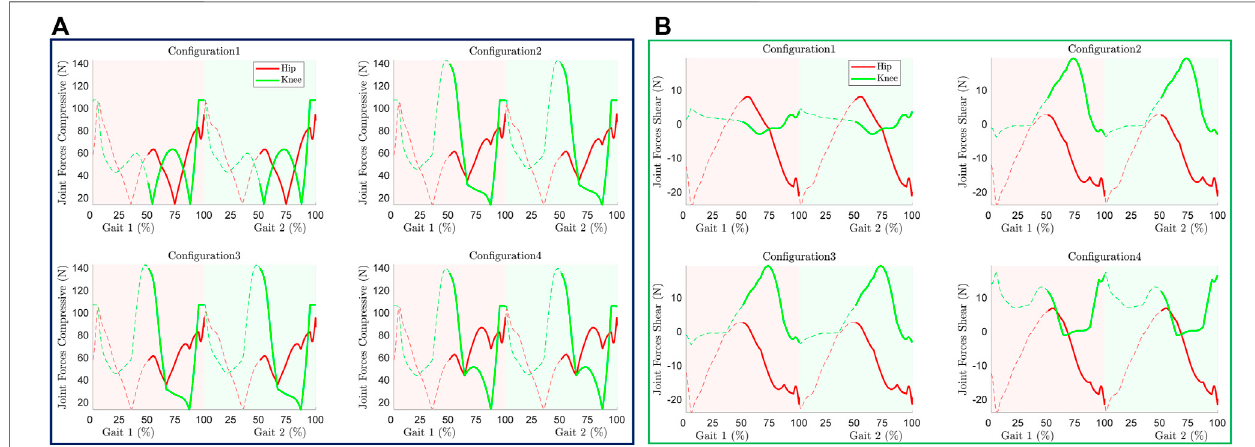
FIGURE 11 | Joint component forces induced due to cable tension (A) Compressive, (B) Shear.